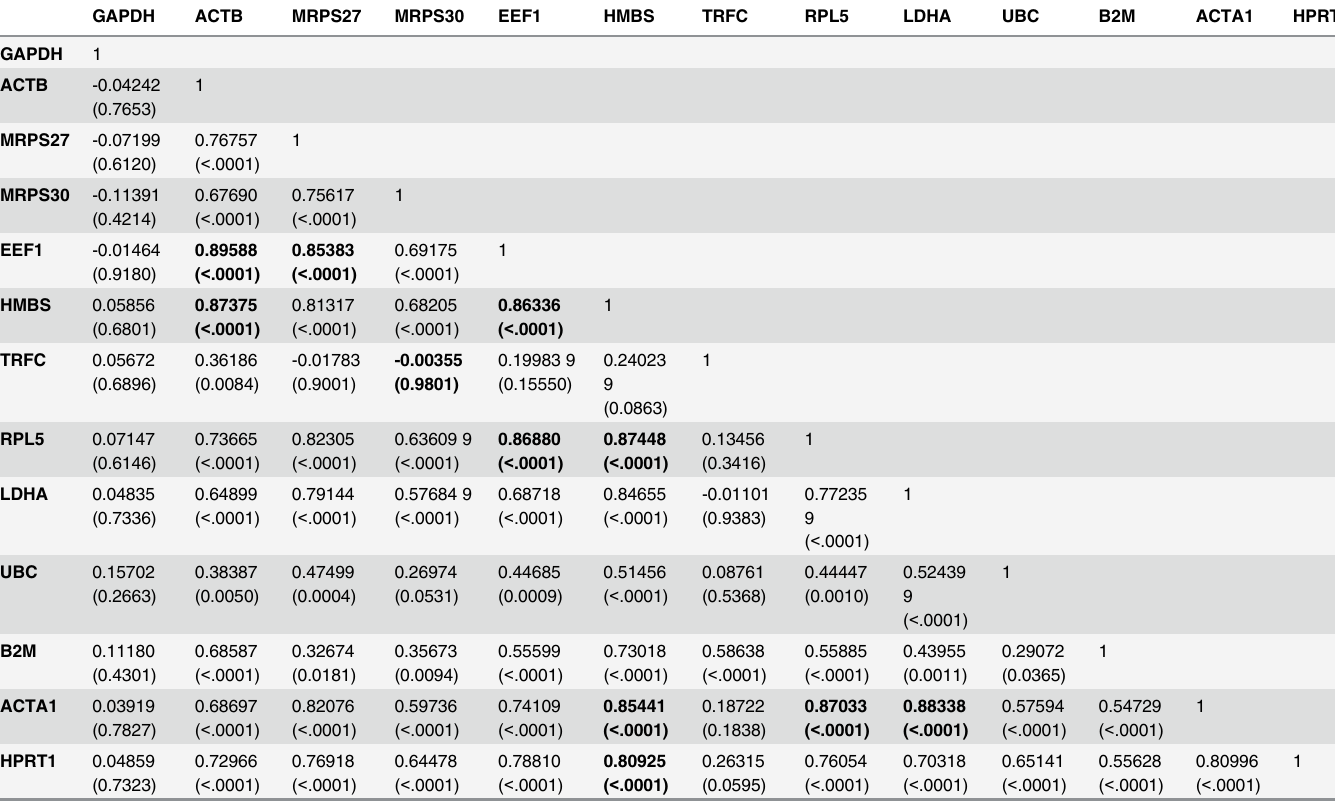
Table 5. Pearson correlation matrix visualizing reference genes ranked by five different stability tests (BestKeeper, NormFinder, geNorm Excel, geNorm SAS, and Δ Ct method. p-value are described are in parenthesis. Significative values are indicated in bold. GAPDH